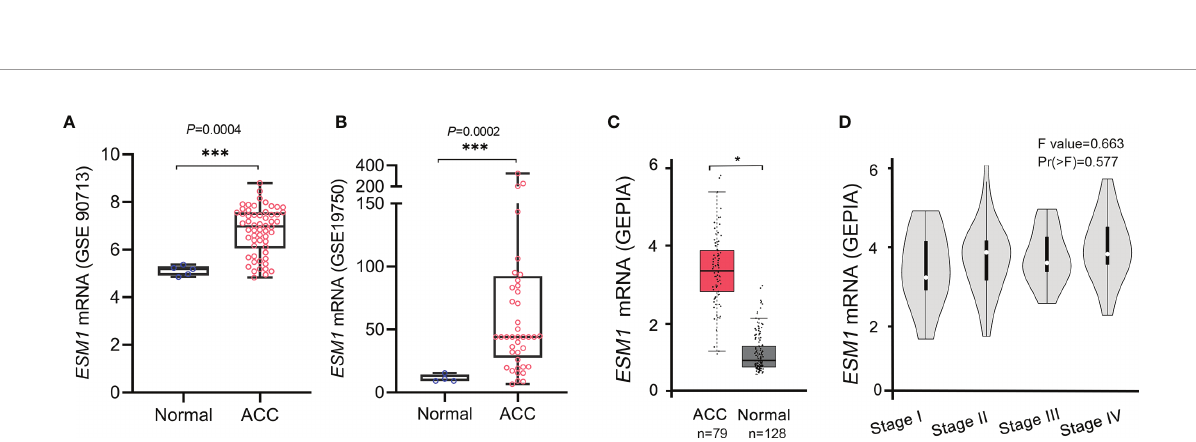
FIGURE 1 | ESM1 is overexpressed in ACC patients, compared with normal adrenocortical samples or adrenocortical adenoma. (A) IHC for HE (upper) and ESM1 protein expression (bottom) in normal adrenal cortex, adrenocortical adenoma, and ACC samples (high power fi elds, ×400). (B) Combined ESM1 score in ACC, adrenocortical adenoma, or normal adrenal cortex tissues. ** p < 0.01, *** p < 0.001.